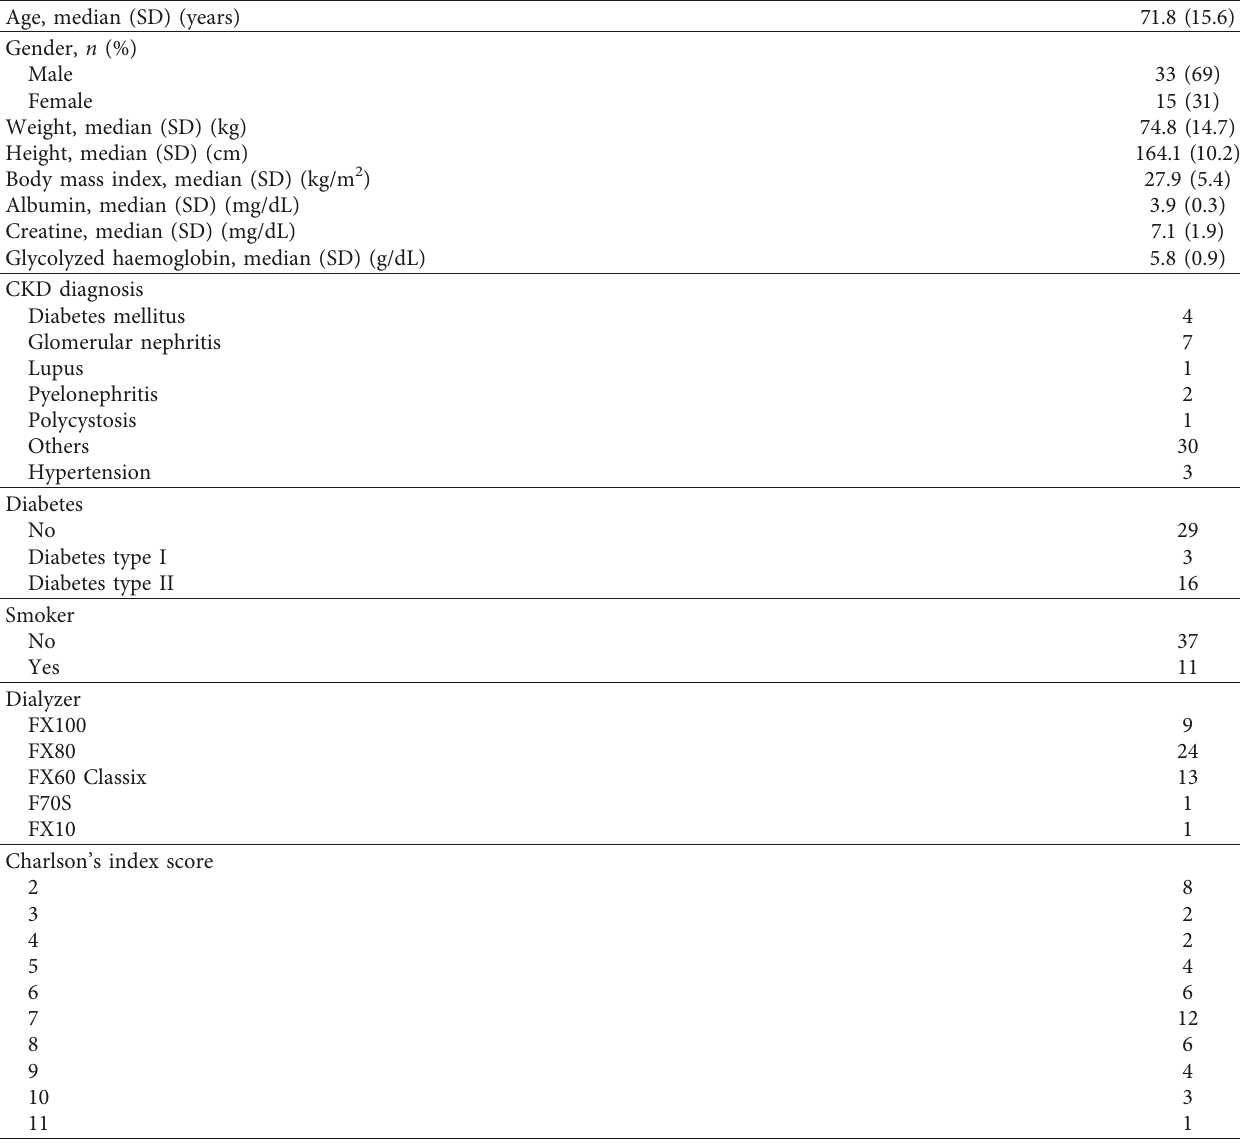
Table 1: Demographic characteristics of the